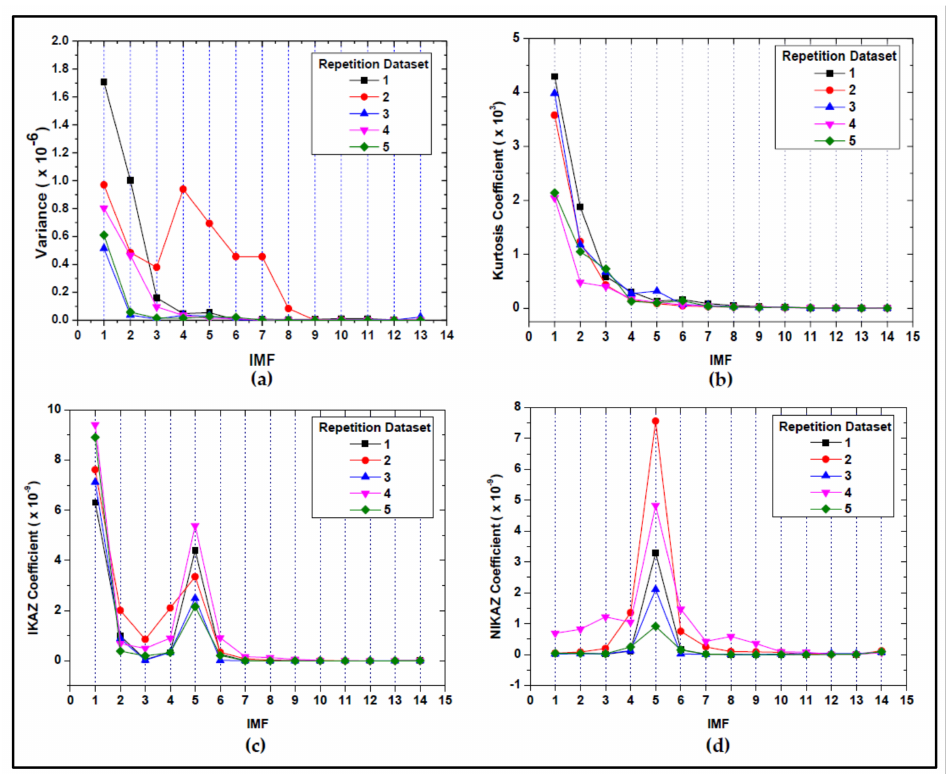
Figure 18. The curve for 5 mm leak IMFs induced on fire hydrant 3: ( a ) Variance, ( b ) Kurtosis, ( c ) IKAZ, ( d ) NIKAZ.